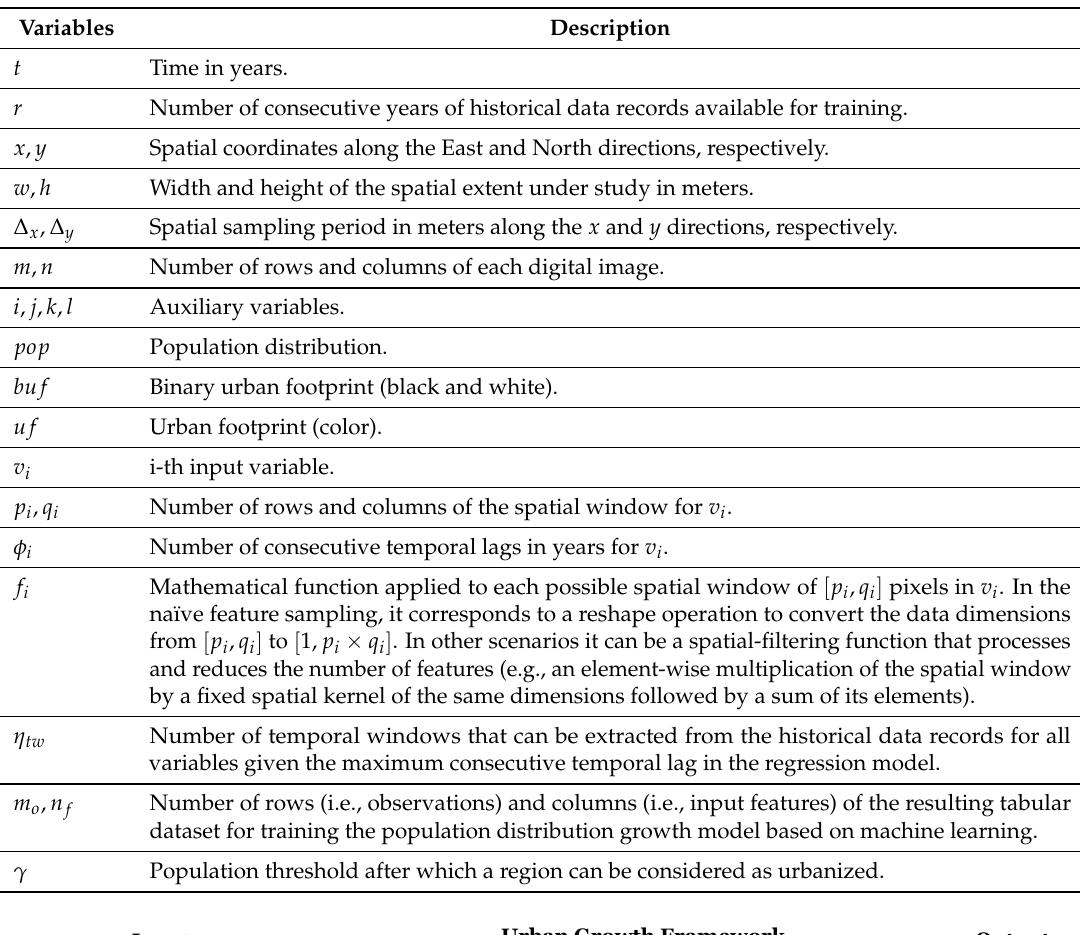
Table 2. Terminology of the urban growth framework.